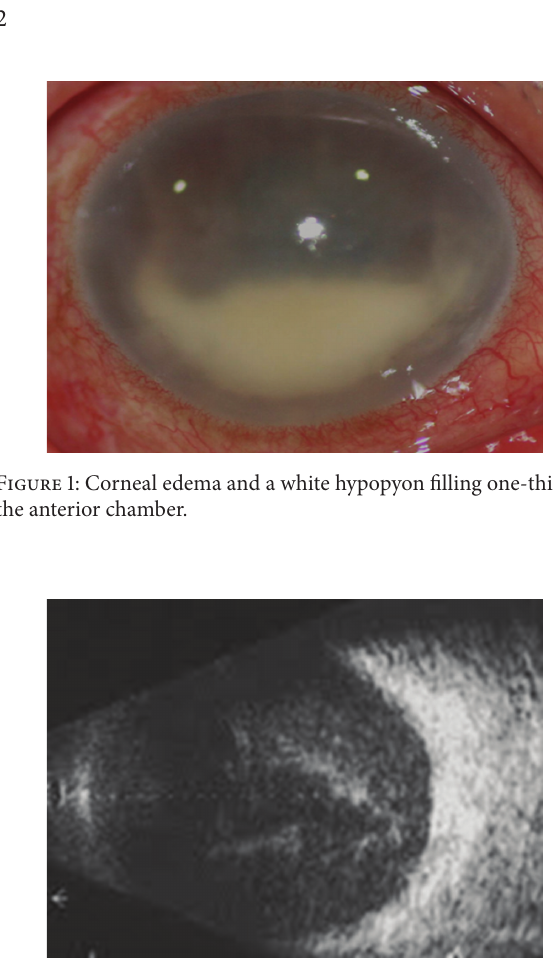
Figure 2: Ultrasonography OD—diffuse vitreous condensation.